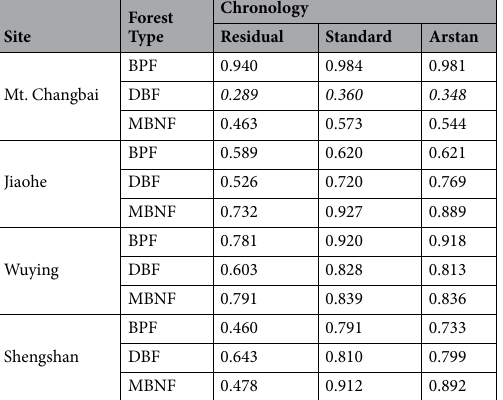
Table 2. Correlations between stand NPP time-series and tree ring chronologies for three forest types in four sites. All correlations were significant at 0.05 level expect those in italics . Abbreviations: BPF, Betula & Populus forest; DBF, deciduous broad-leaved forest; MBNF: mixed broad- & needle-leaved